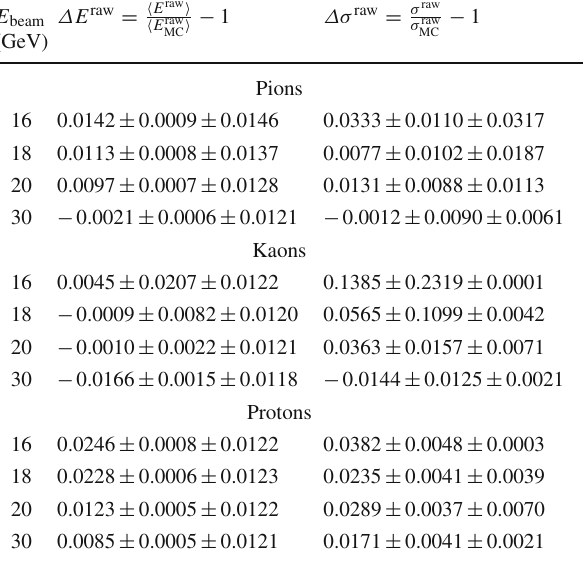
Table8 Comparisonoftheenergyresponse(left)andresolution(right) obtained analyzing experimental and simulated data in the case of pion, kaon and proton beams with different beam energies. Statistical uncer- tainties (first value) and systematic uncertainties (second value) are